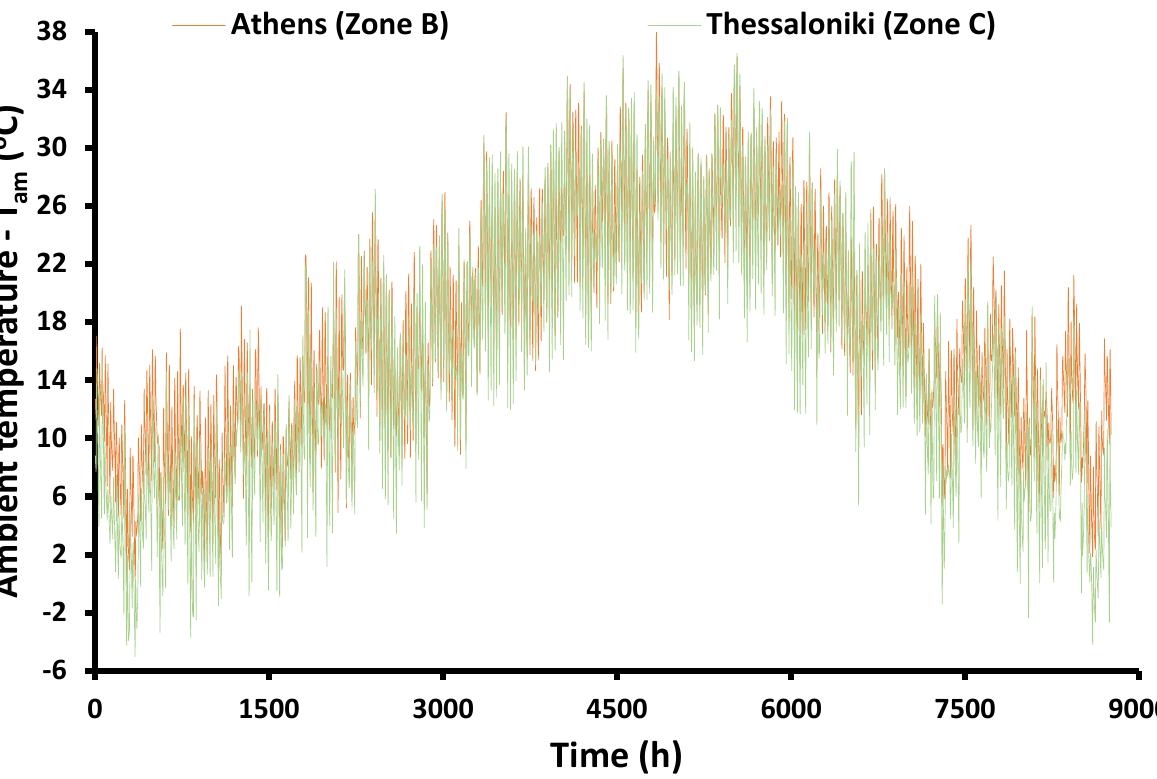
Figure 3. Yearly deviation of the ambient temperature for the examined locations in Greece.